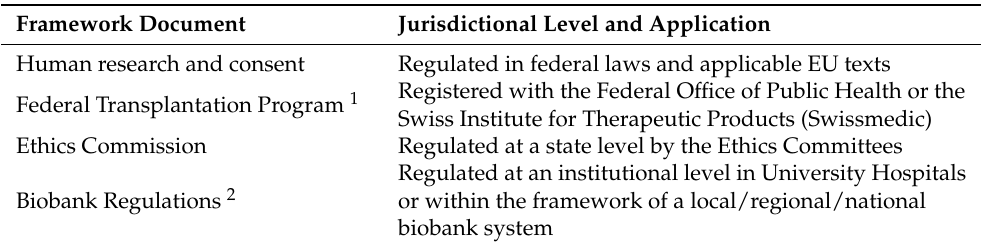
Table 2. Legal and regulatory frameworks involved in modern procurement of tissues for primary diploid cell type establishment and use in Switzerland. EU, European